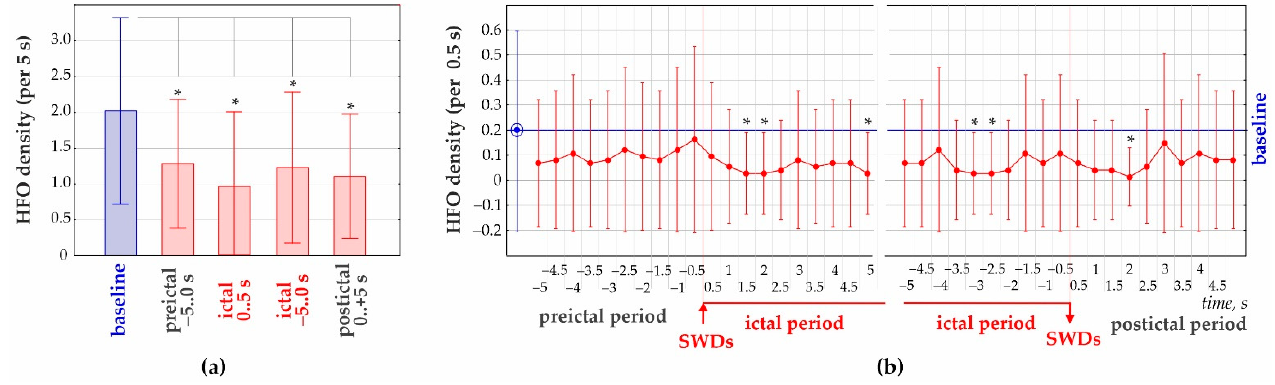
Figure 6. Density of hippocampal 50–70 Hz high-frequency oscillations (HFO) in relation to the presence of spike-wave discharges (SWDs). ( a ) Density of HFOs as measured in 5 s periods; * significant differences from the baseline (the desynchronized state), Bonferroni test, p < 0.05. ( b ) Dynamics of HFO density before, during and after SWDs assessed per 0.5 s; * significant differences from baseline, Bonferroni test, p <